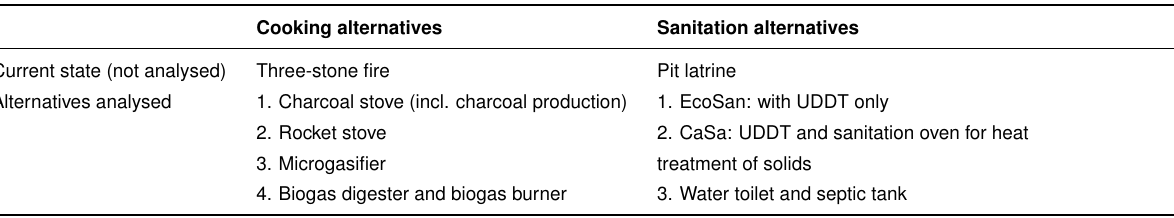
Table 3. Alternatives defined for the sustainability assessment of small-scale cooking and sanitation technologies that are, technically and commercially, available to smallholders in Karagwe, Tanzania Cooking alternatives Sanitation alternatives Current state (not analysed) Three-stone fire Pit latrine Alternatives